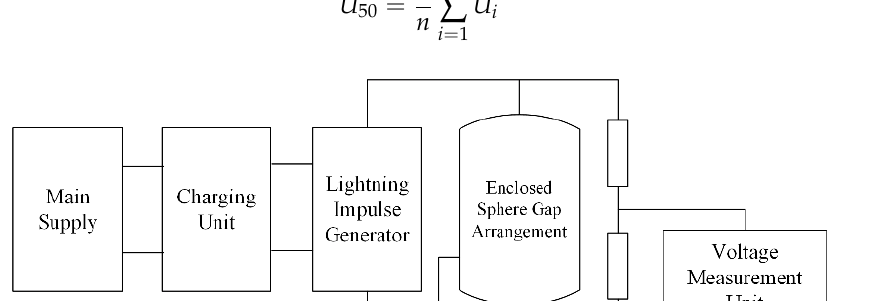
Figure 12. ( a ) Various components used in the experimental setup; ( b ) Lightning impulse and disruptive discharge arrangement at different gas pressures.